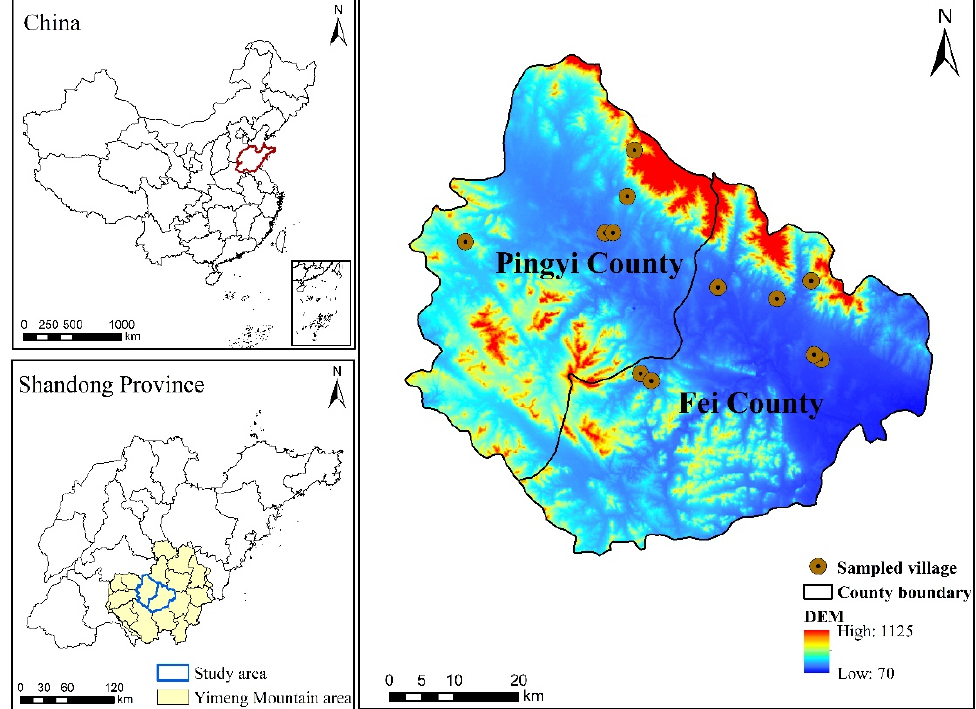
Figure 1. Geographic location of the study area.